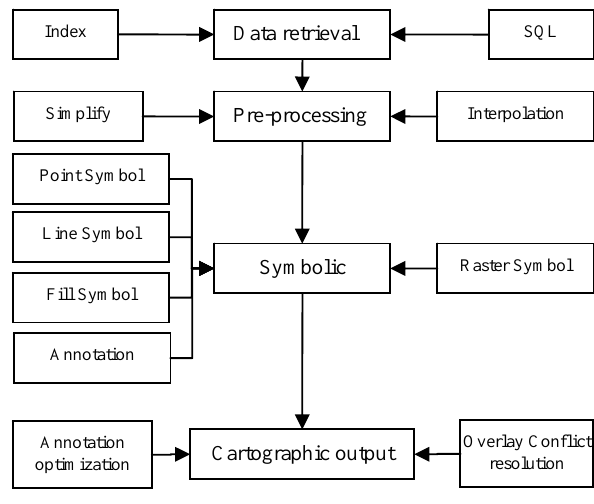
Figure 2 Data Visualization